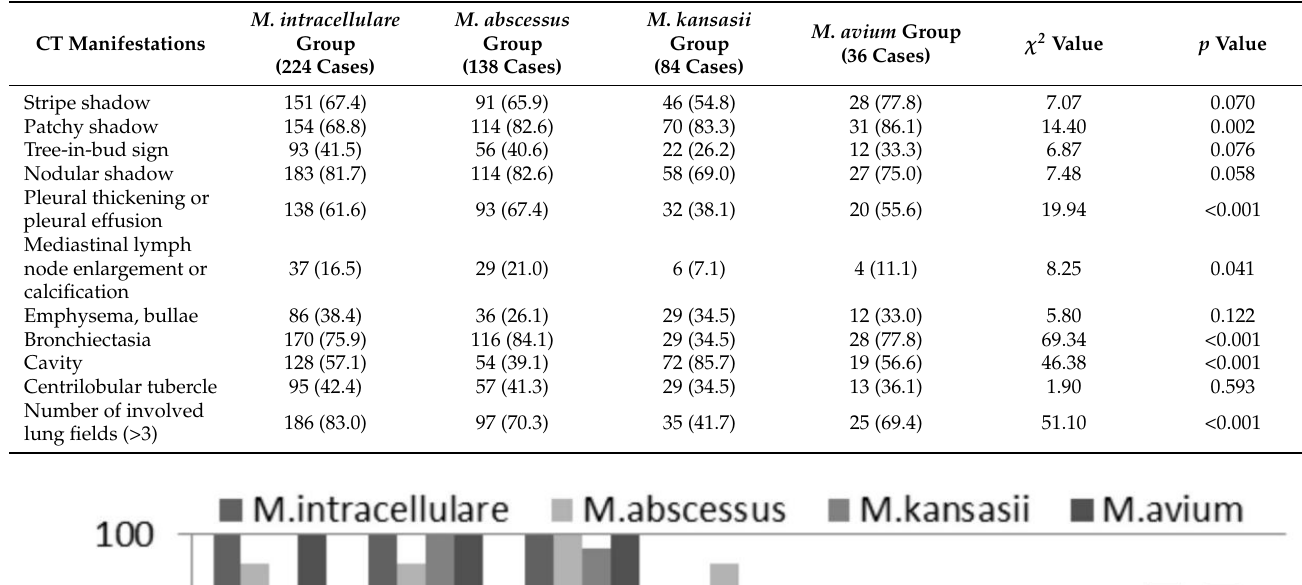
Table 2. Chest CT imaging manifestations of patients with NTM in four groups ( n , %).